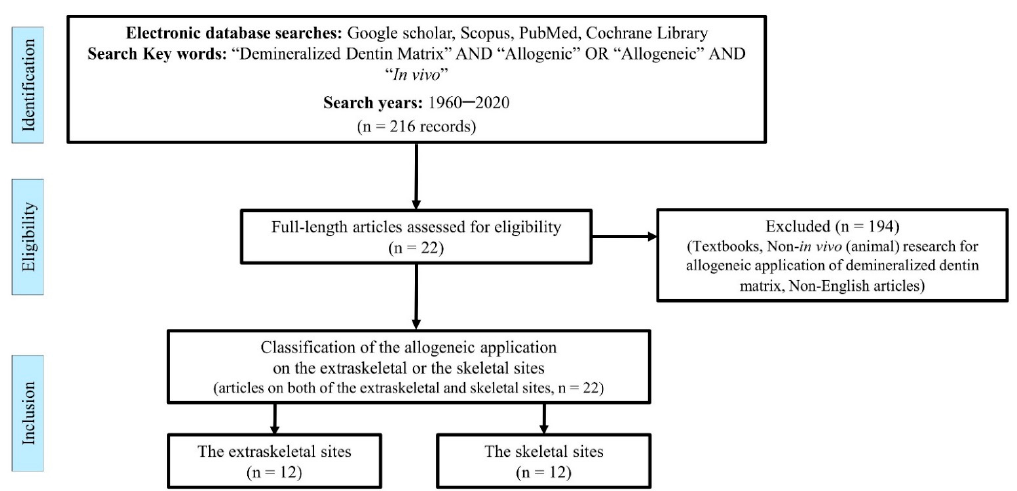
Figure 1. Flow diagram for the review process.